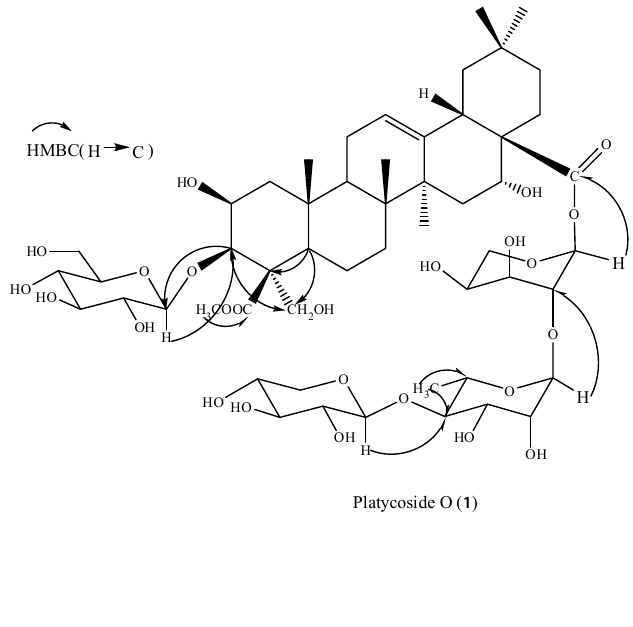
Figure 2. The structure and selected HMBC correlations of 1